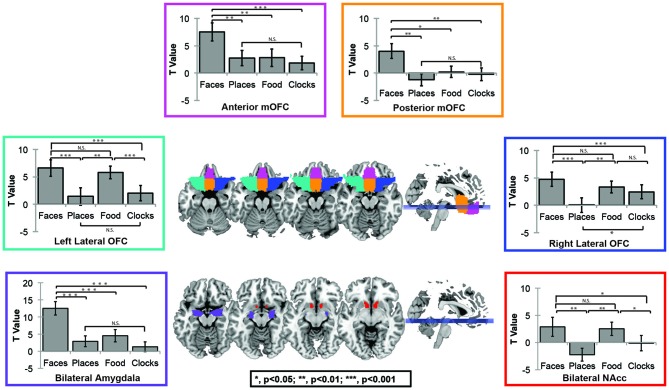
Automated Anatomical Labeling (AAL) Atlas region of interest (ROI) Figure. The AAL atlas was used to define masks for four OFC subregions including left (green) and right (blue)lateral OFC, posterior mOFC (orange), and anterior mOFC (pink), bilateral AMY (purple) and bilateral nucleus accumbens (red).